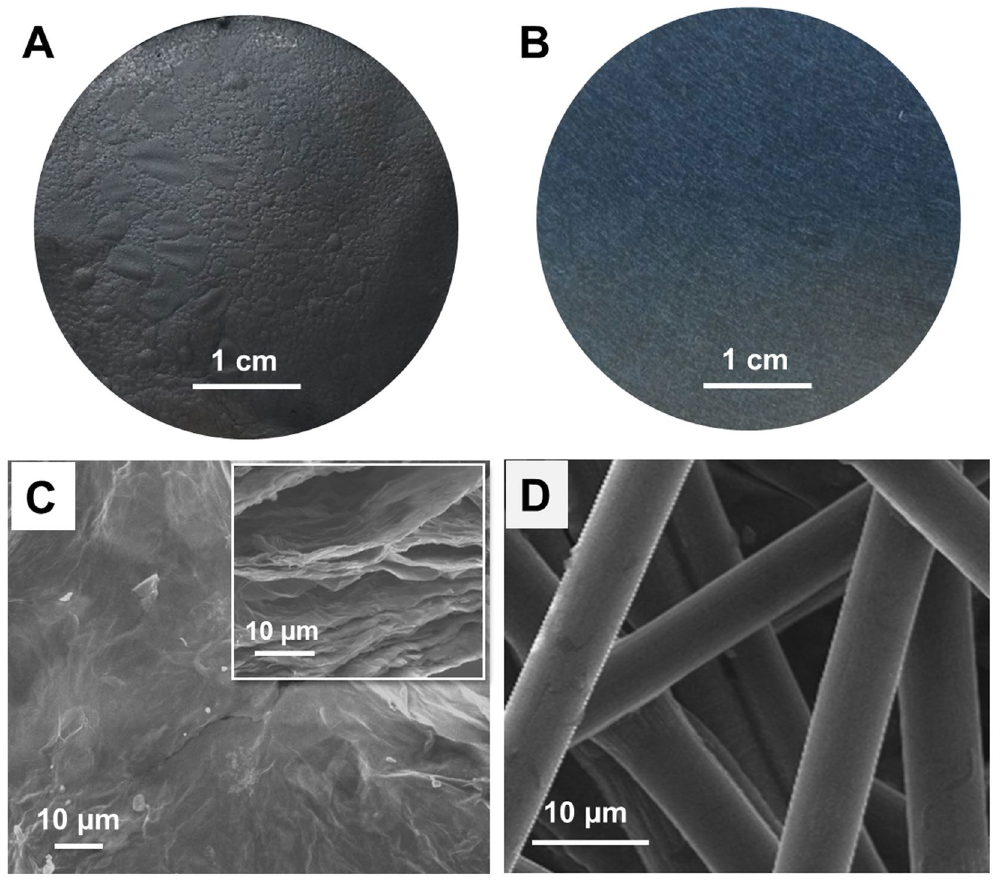
Figure 1. Digital pictures and SEM images of ( A , C ) a freestanding RGO paper cathode and ( B , D ) a freestanding carbon paper cathode. Inset of panel C is a cross-sectional SEM image of RGO